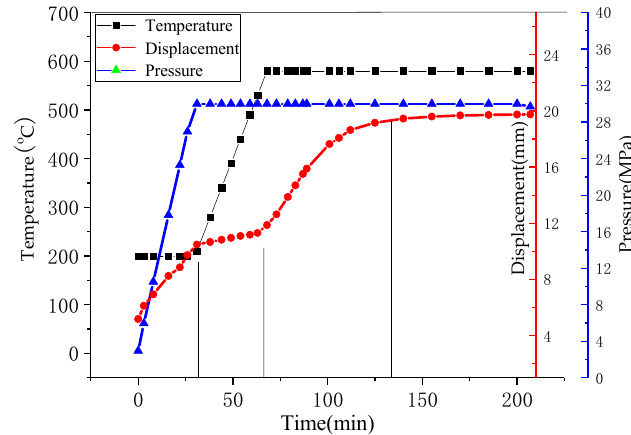
Figure 4. The variant on the curves of temperature, pressure, and pressure head displacement with time.